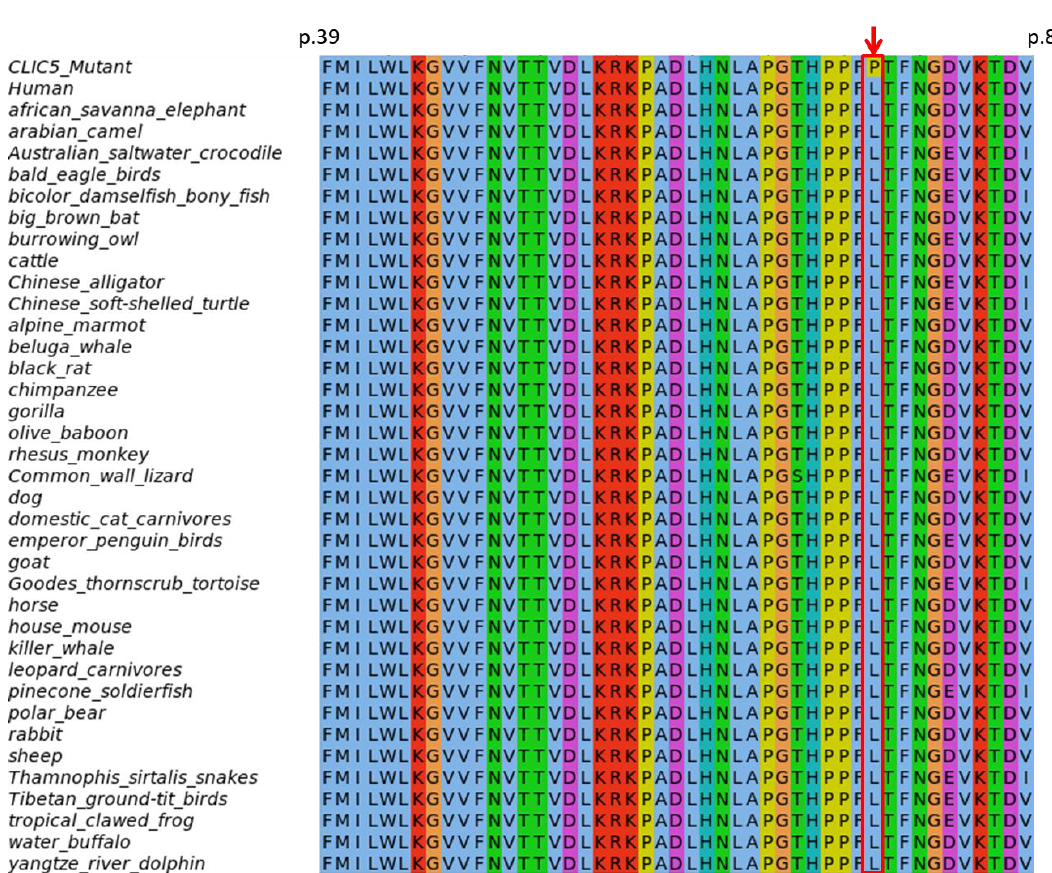
Genes 2020 , 11 , x FOR PEER REVIEW 8 of 13 the long isoform of CLIC5 [NM_001114086.1:c.701T>C:p.(L234P)] (Figure 3c). We found that there